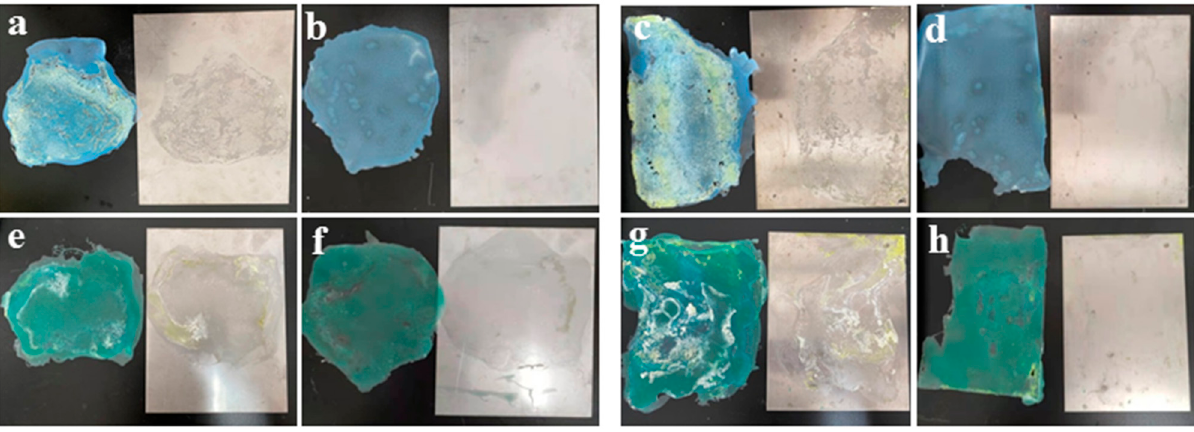
Figure 7. Photographs of high surface contamination levels: ( a , b ) 1st and 2nd CL decontamination of 5 g/L; ( c , d ) 1st and 2nd C1 decontamination of 22.5 g/L; ( e , f ) 1st and 2nd DeconGel decontamination of 5 g/L; ( g , h ) 1st and 2nd DeconGel decontamination of 22.5 g/L.